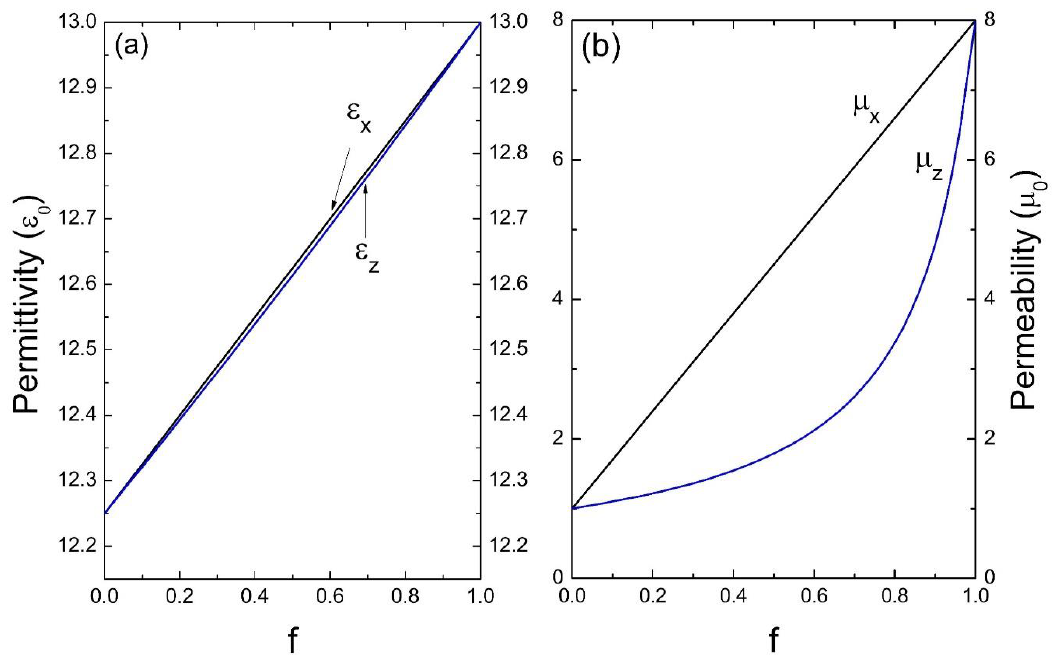
Figure 2. Permittivity ε ( a ) and permeability μ ( b ) versus the filling fraction f (ε 0 and μ 0 are the units).